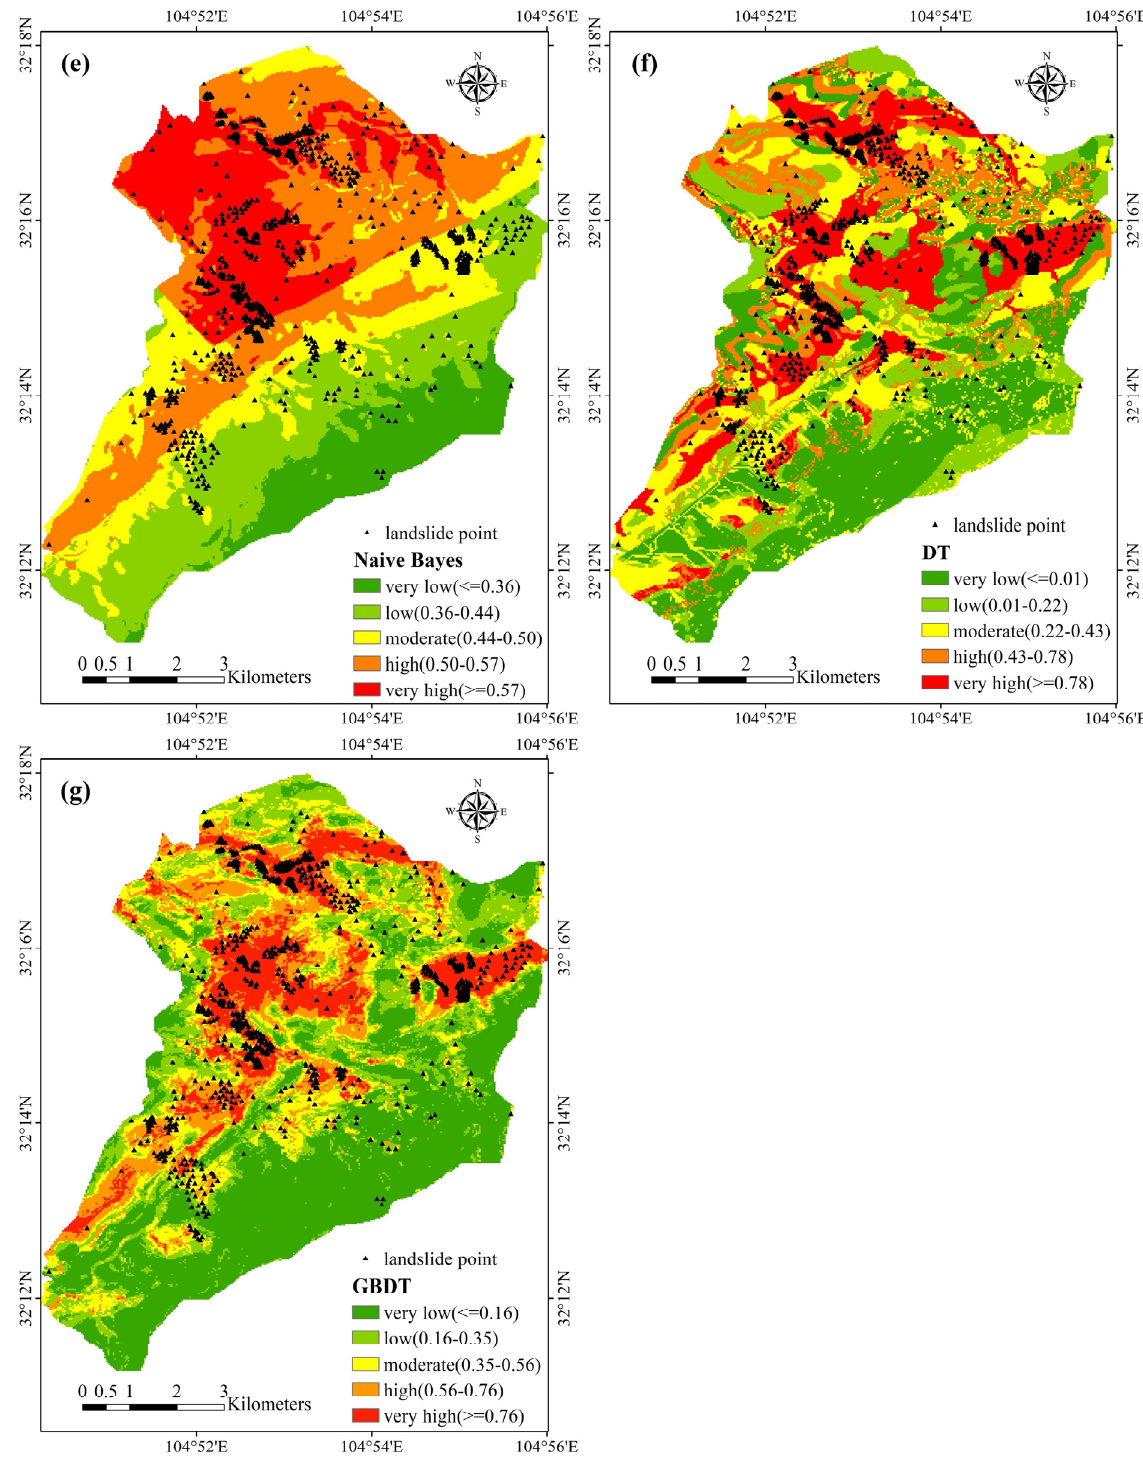
Figure 6. Landslide susceptibility maps: ( a ) CNN, ( b ) Adaboost, ( c ) MLP-NN, ( d ) RF, ( e ) Naïve naive Bayes, ( f ) DT, ( g ) GBDT. Bayes, ( f ) DT, ( g )